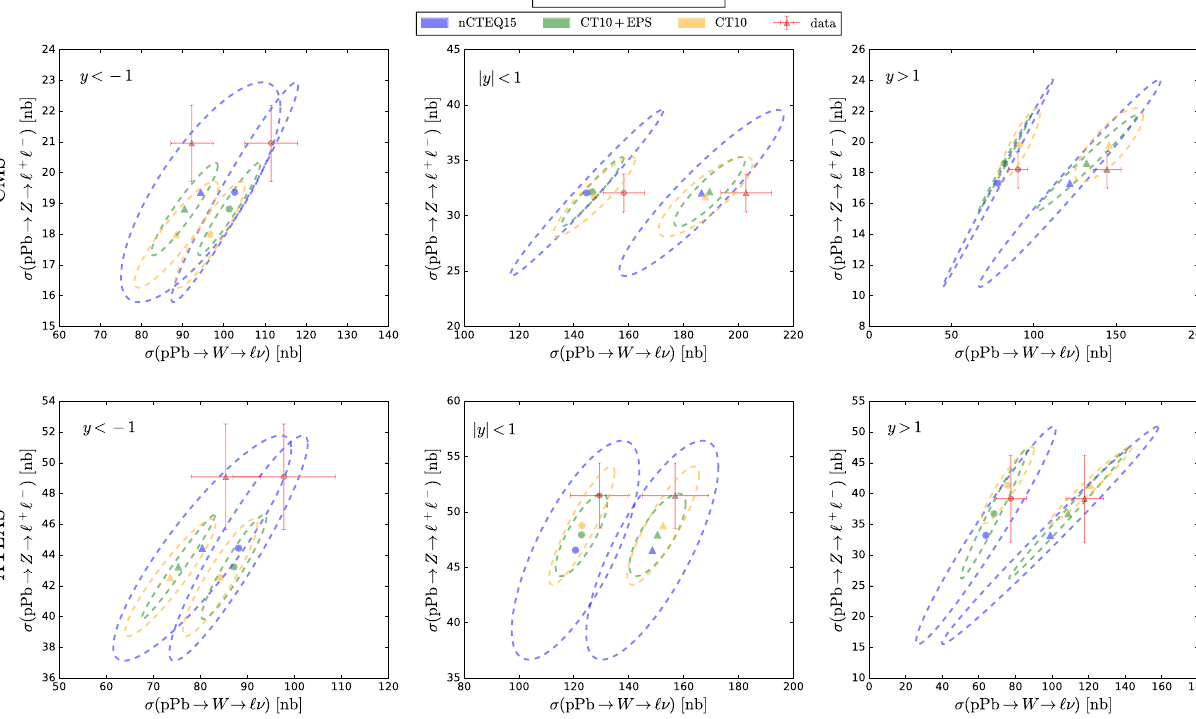
Fig. 12 Correlations between Z and W + / W − cross sections calculated with different PDFs overlaid with the corresponding LHC data from CMS and